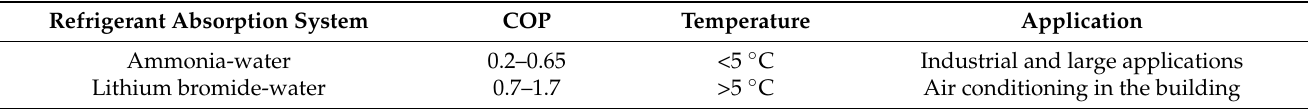
Table 2. Characteristics of refrigerants used in absorption